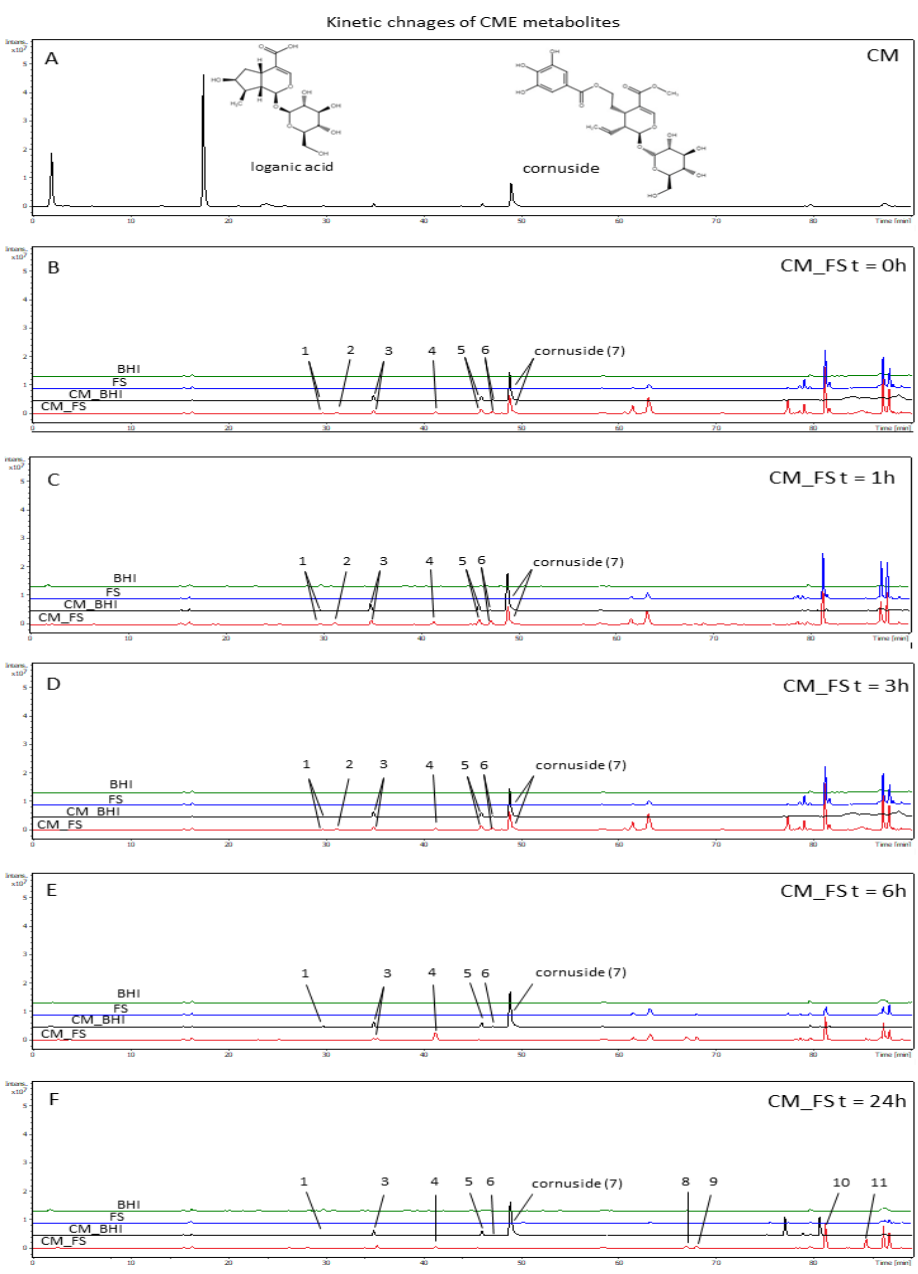
Figure 4. Ion chromatograms of ethanolic-aqueous extract from fruits of C. mas (CM; ( A )) after the treatment with FS for 0 h ( B ), 1 h ( C ), 3 h ( D ), 6 h ( E ), and 24 h ( F ).